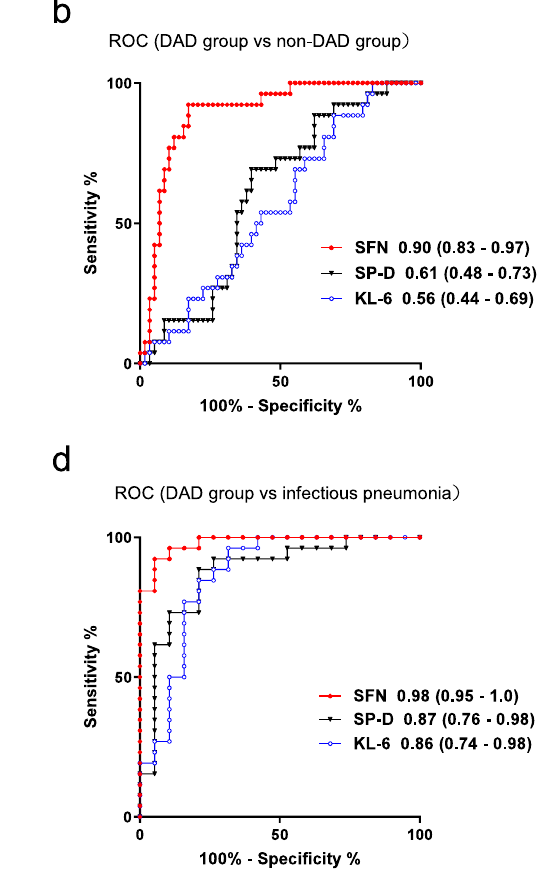
DILD types (DAD diagnostic performance), c the DILD-tolerant control patients (DAD onset), and d patients with infectious lung disease. Values in parentheses indicate the area under the curve (AUC) values. Source data are provided as a Source data fi